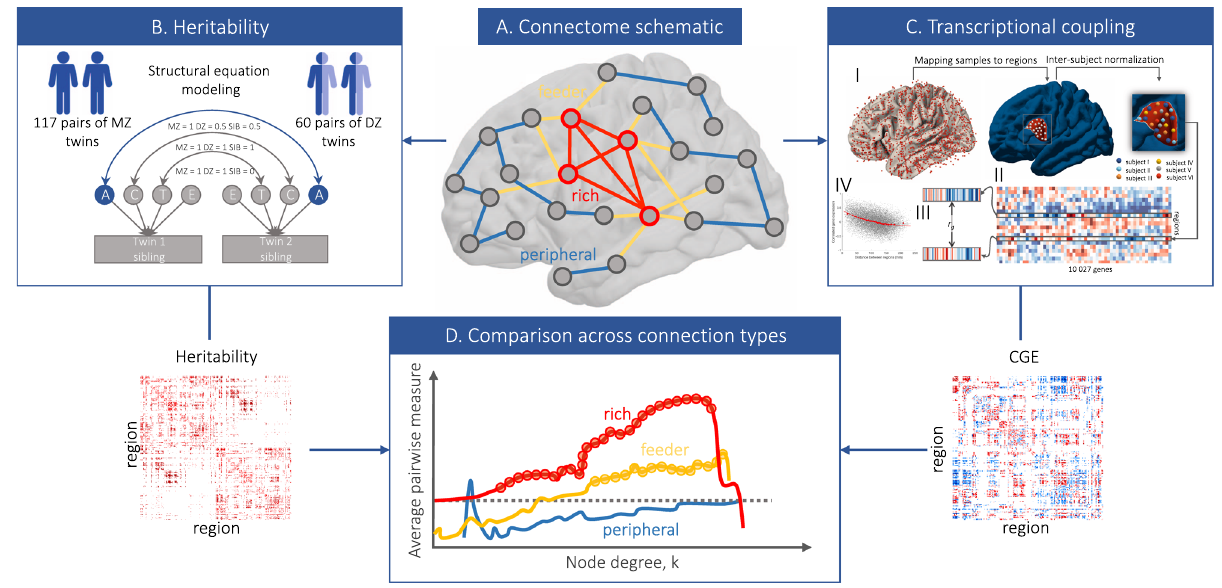
Fig. 1 Work fl ows used to characterize genetic in fl uences on hub connectivity. A A schematic representation of the connectome showing different connection types in the brain. Given a distinction between hub nodes (red outline) and nonhub nodes (gray outline), we can delineate three classes of connections: rich links — connections between two hubs (red); feeder links — connections between a hub and a nonhub (yellow); and peripheral links — connections between two nonhubs (blue). B Connectome-wide heritability analysis. We use structural equation modeling to fi t a classic ACTE biometric model to every connection within the brain, resulting in estimates of genetic and environmental in fl uences for each link. C Analysis of transcriptional coupling. (I) Each of 3702 tissue samples in the Allen Human Brain Atlas (AHBA) is mapped to a given region in our brain parcellation. (II) Expression values are then subjected to quality control and processing pipeline 40 to construct a region × gene matrix of expression values. (III) We estimate correlated gene expression (CGE) between each pair of brain regions as the Pearson correlation between region-speci fi c gene-expression pro fi les. (IV) Inter-regional CGE is corrected for spatial autocorrelation of the expression data via regression of an exponential distance trend 40 . D Schematic representation of how values assigned to each edge are compared across connection types. We compare the mean of edge-level (pairwise) measures of heritability and CGE for rich, feeder, and peripheral links across all possible hub-de fi ning thresholds (horizontal axis). As k increases, the de fi nition of a hub becomes more stringent and identi fi es the actual hubs of the network. Thus, if a given effect is stronger for rich links, we expect the pairwise estimates to increase as a function of k , with the increase for rich links being particularly large relative to the feeder and peripheral